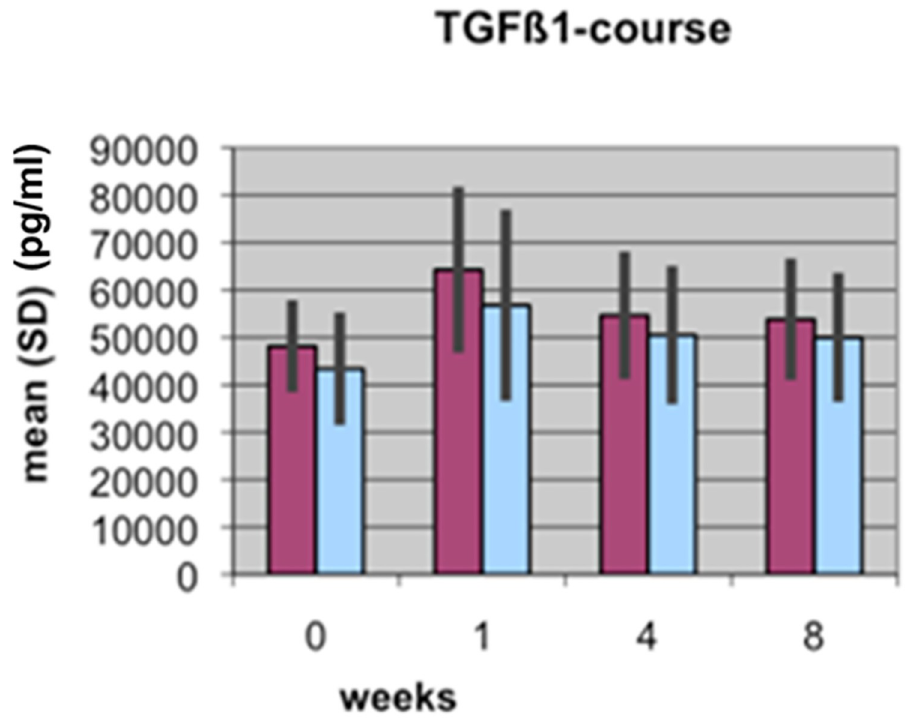
Fig 2. Course of TGFß1 serum concentration (pg/ml) during fracture healing of eight weeks in low BMD versus normal BMD patients. (Dark bars: low BMD group, light bars: normal BMD group). Statistics were performed using the software SPSS 11.0.0 (IBM Germany, Munich, Germany), Friedman test, Wilcoxon rank test and Mann-Whitney U tests were used. P � 0.05 was considered to be significant, p � 0.01 as very significant, and p � 0.001 as highly significant. Different levels of significance are marked by one to three